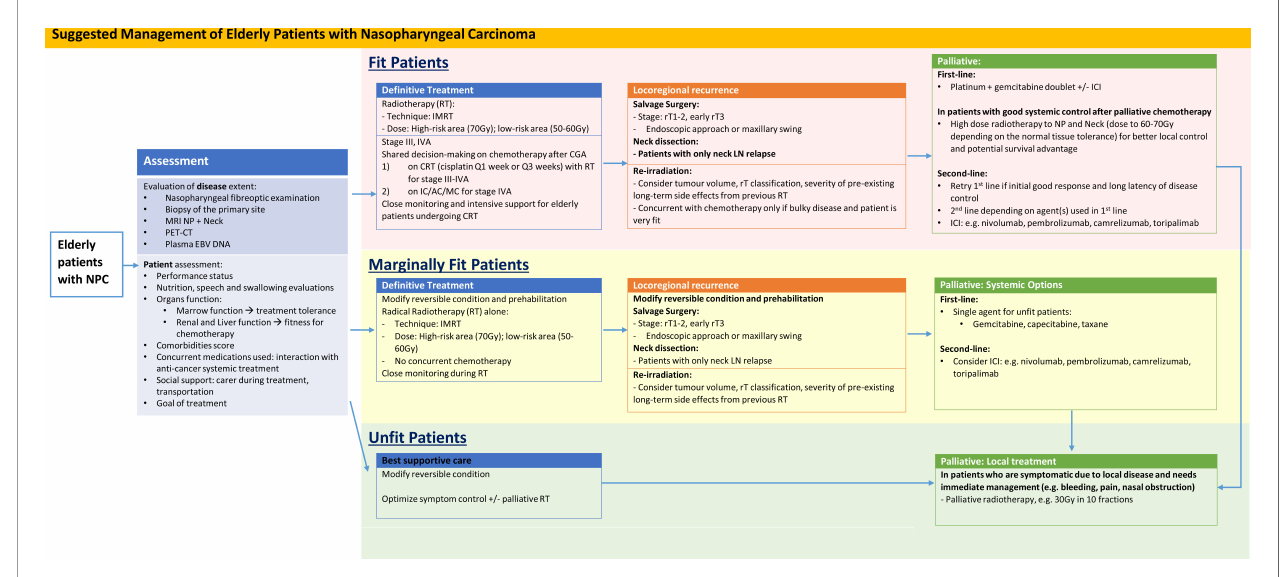
FIGURE 1 | Suggested Management of Elderly Patients with Nasopharyngeal Carcinoma. AC, adjuvant chemotherapy; CRT, concurrent chemoradiation; IC, induction chemotherapy; ICI, immune checkpoint inhibitors; IMRT, intensity modulated radiotherapy; LN, lymph node; MC, metronomic chemotherapy; NP, Nasopharynx; RT,